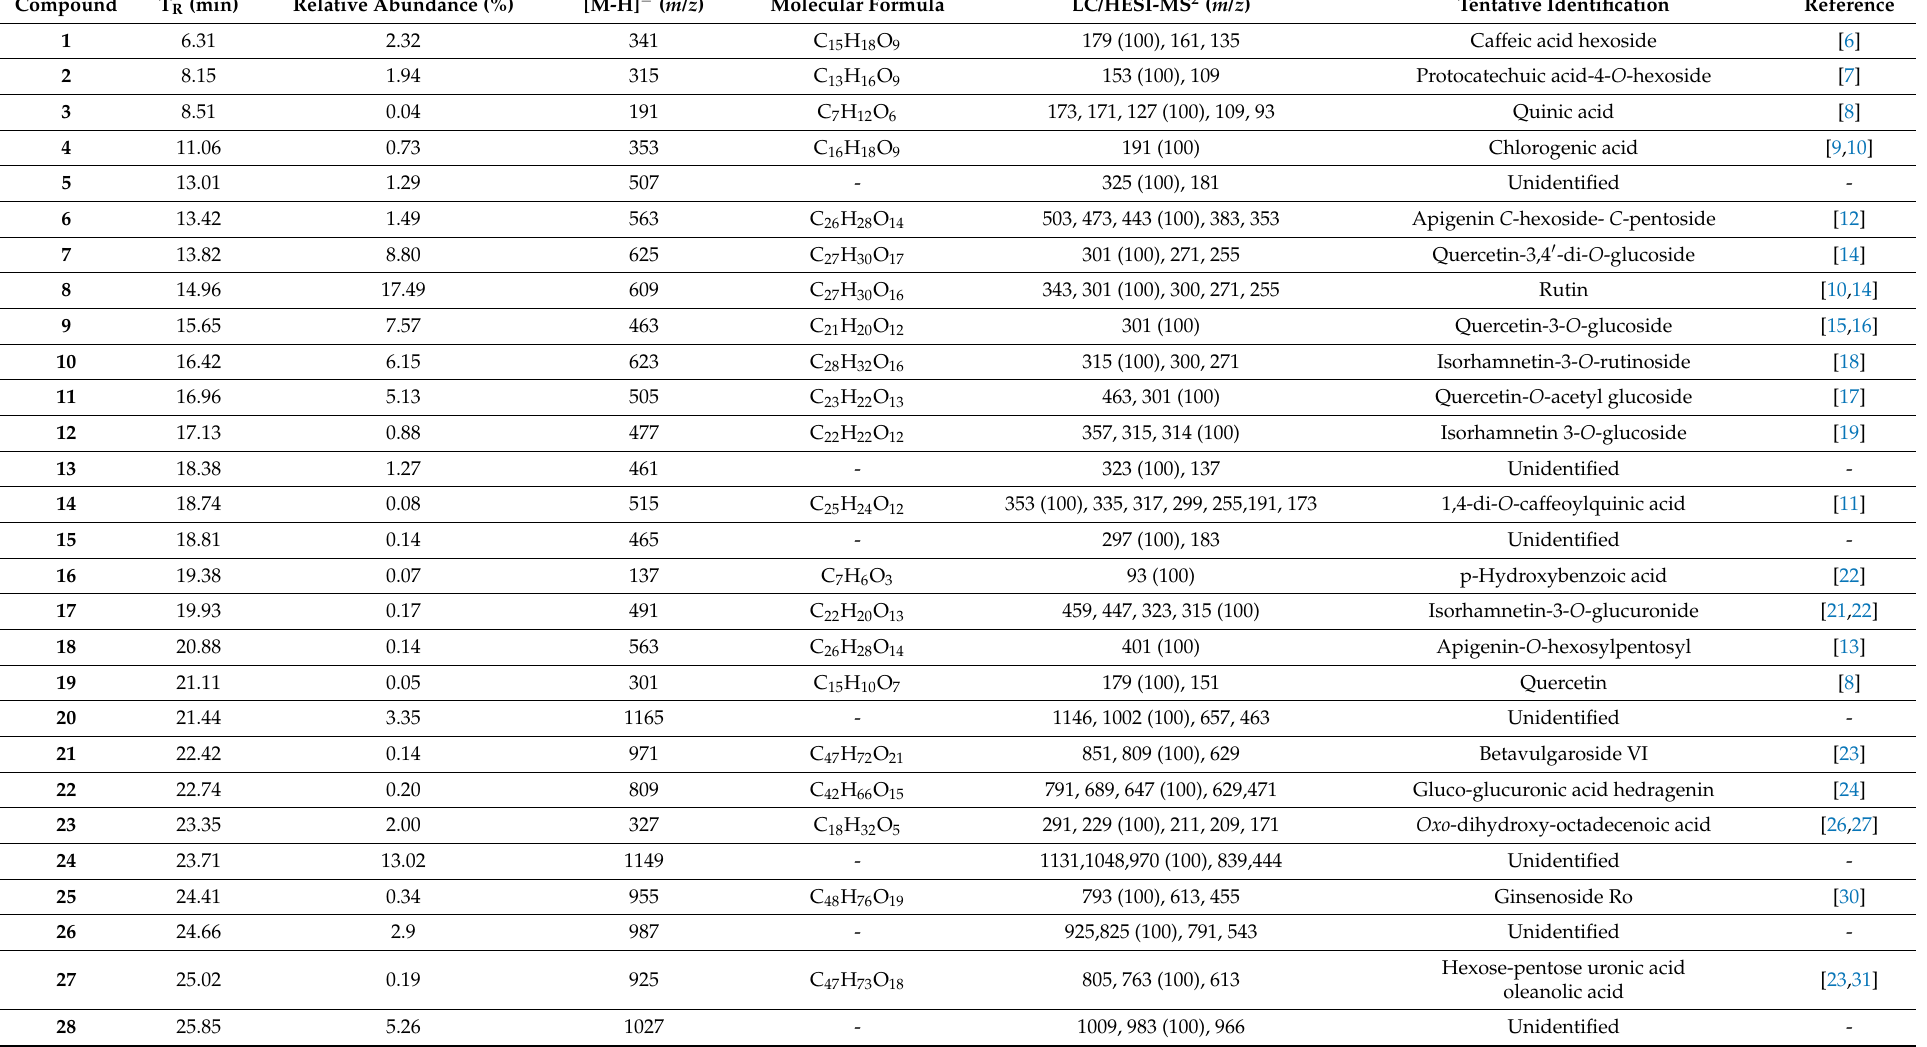
Table 3. Compounds from C. aegyptiaca fruits (MeOH extract) identified through LC–MS/MS (negative